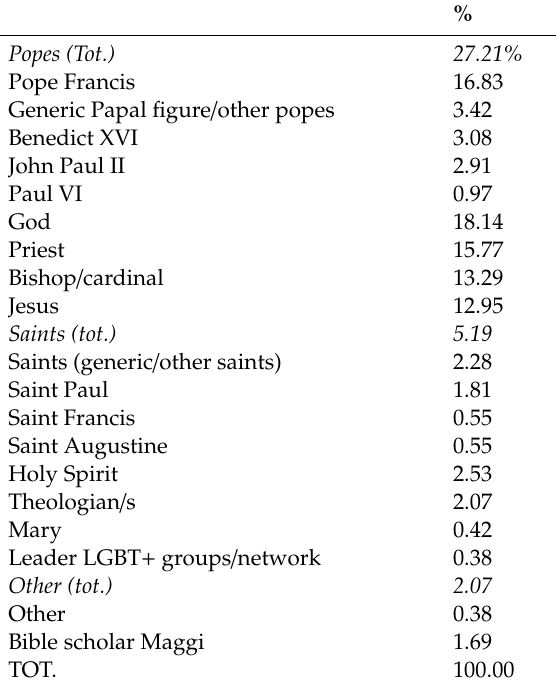
Table 1. Religious